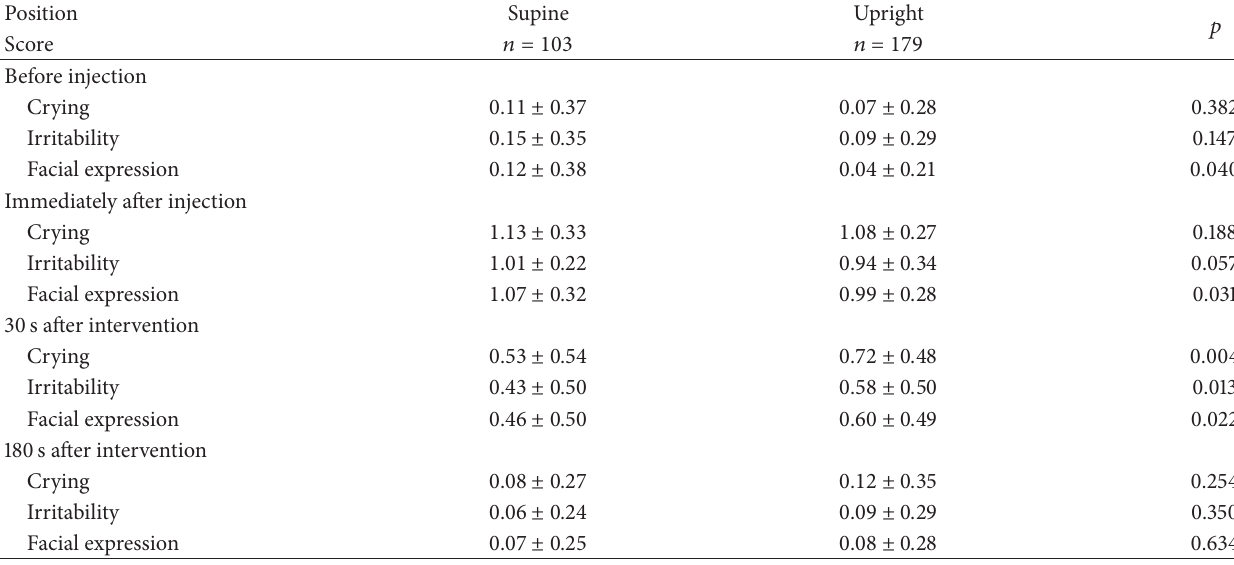
Table 3: Comparison of pain scores between the supine and upright positions ( 𝑛 = 282 ).